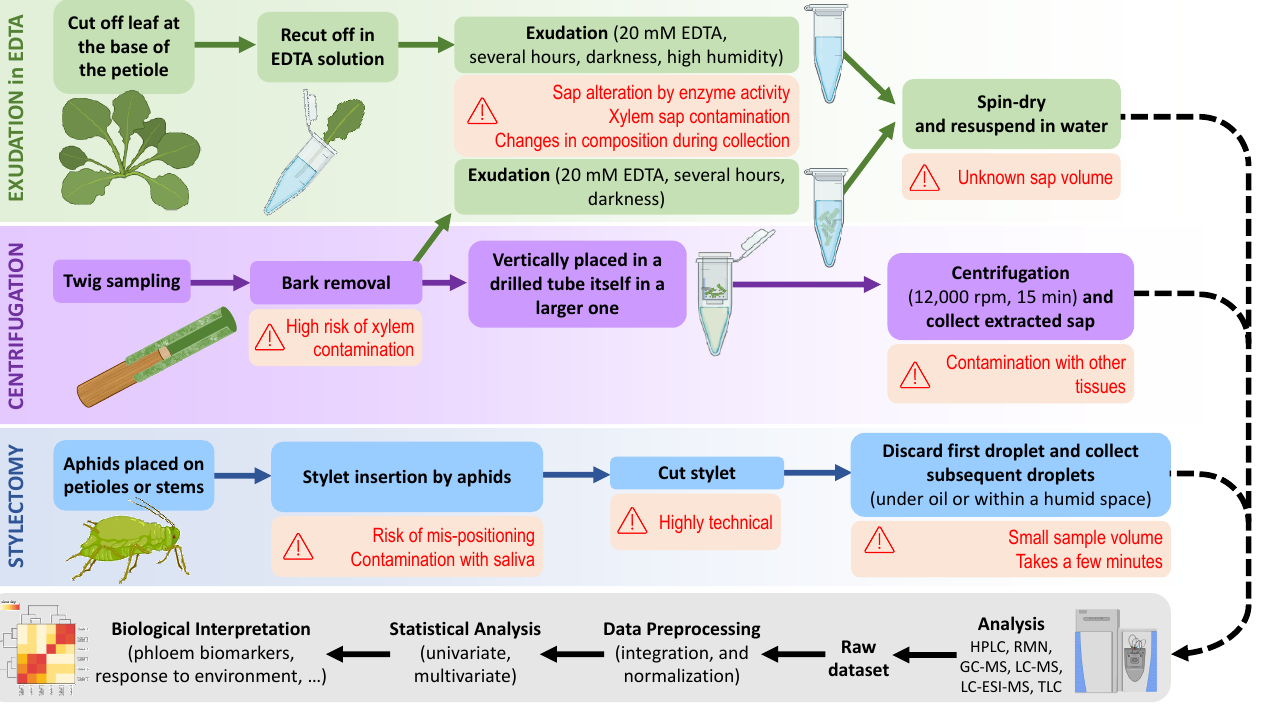
Figure 1. Summary chart of mainstream methods to sample and analyze phloem sap and potential biases associated with them (in red). See main text for further details.